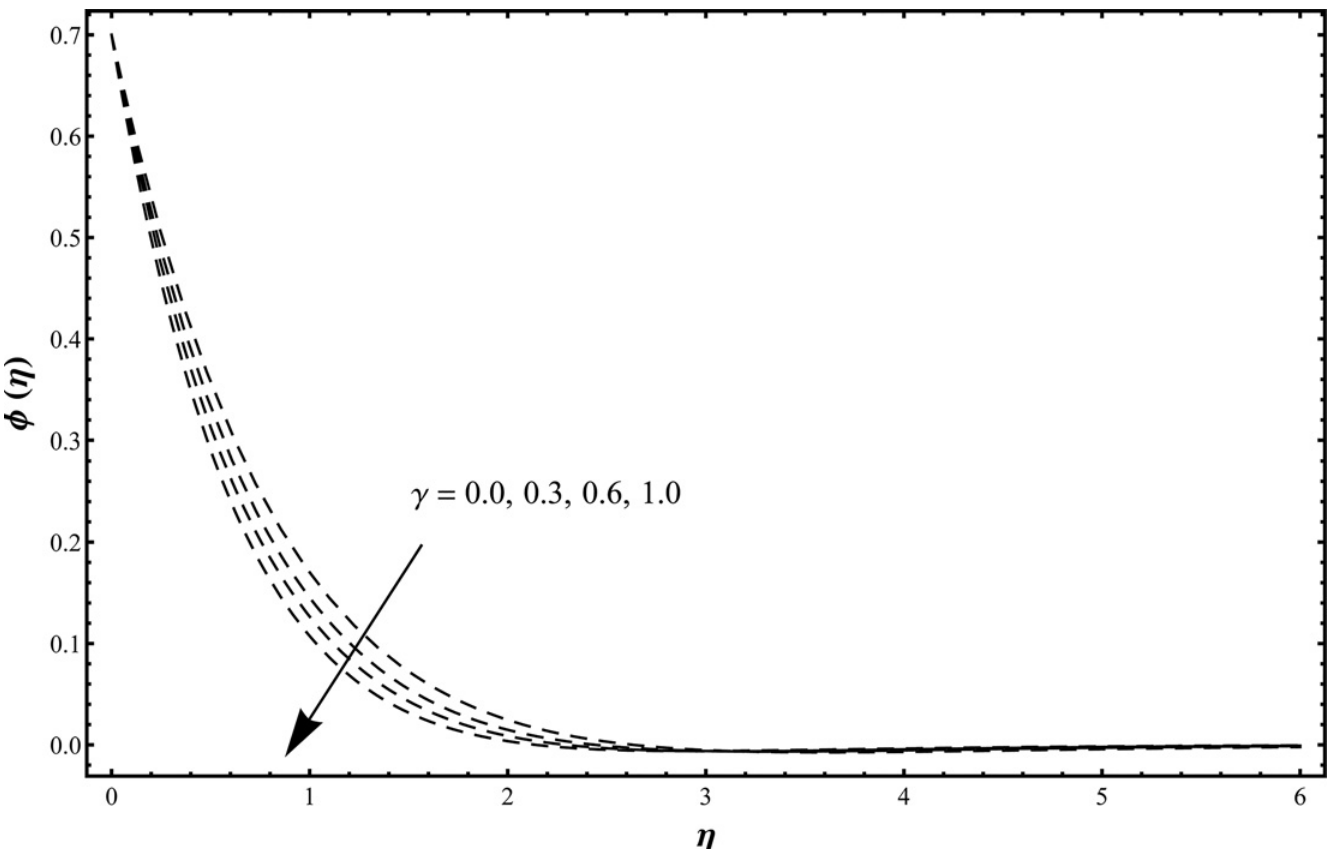
Fig 9. Concentration distribution function ϕ ( η ) when γ = 0.0, 0.3, 0.6, 1.0 and β 1 = β 2 = 0.2 = Rd , λ = 0.1 = N , Pr = 1.0 = Sc , ε 1 = 0.3 = ε 2